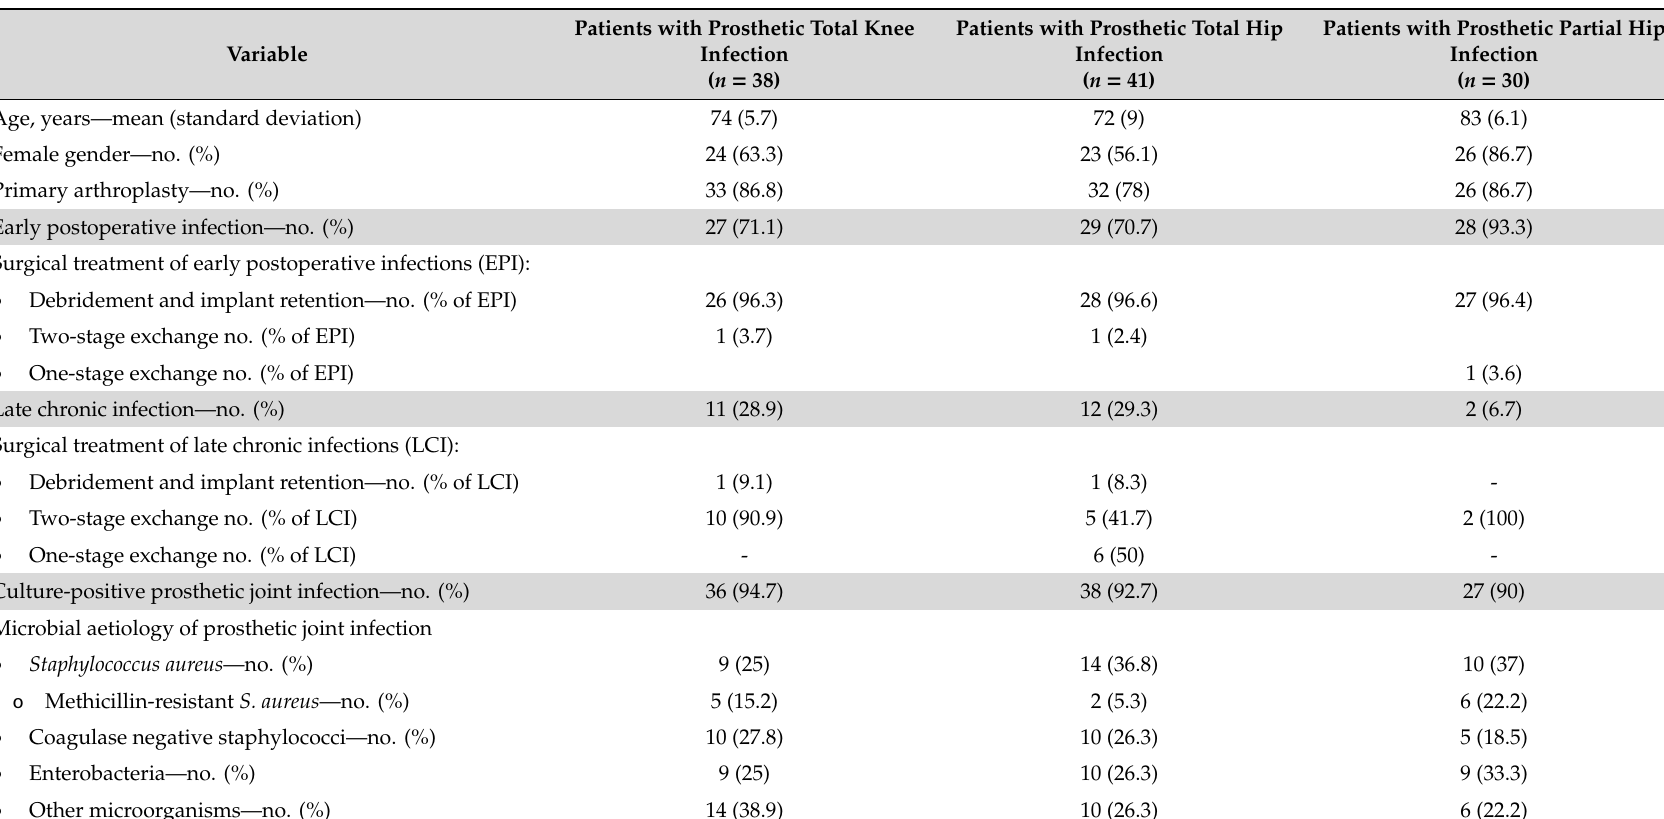
Table 1. Characteristics of 109 patients with hip and knee prosthetic joint infection. Patients with Prosthetic Total Knee Patients with Prosthetic Total Hip Patients with Prosthetic Partial Variable Infection ( n = 38)